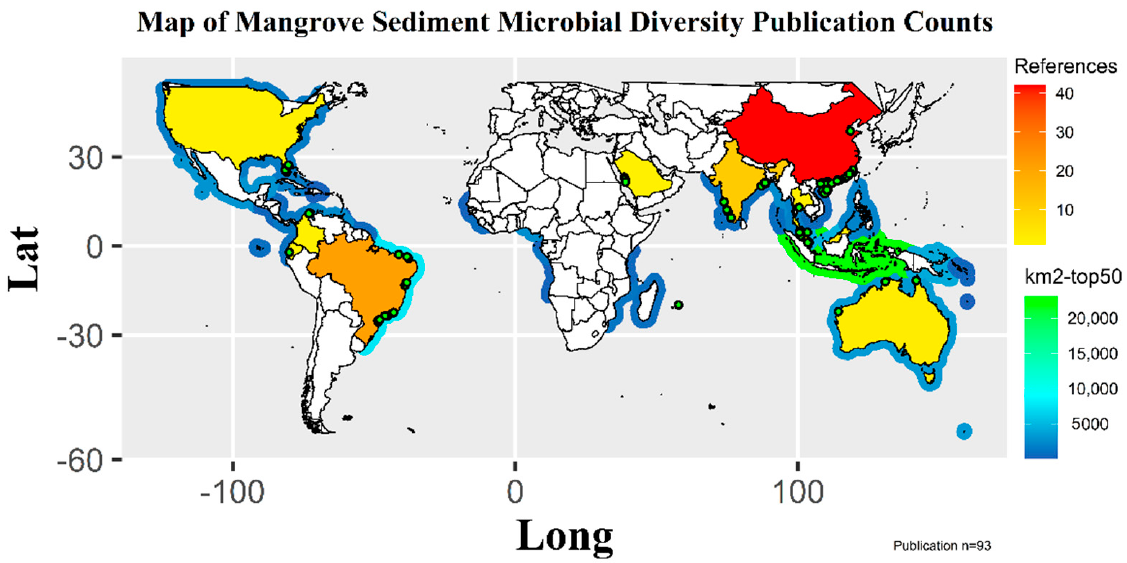
Figure 2. Map of mangrove sediment microbial diversity publication counts. The country polygon fill gradient indicates the number of publication counts while the polygon outline represents the top 50 mangrove coverage in km 2 according to the continuous mangrove forest cover for the 21st century (CGMFC-21) created by Hamilton et al. [4]. The green plots are the sampling plots of each publication. The figure was generated using the ggplot2 package [39] in R [40] using the Mercator projection.